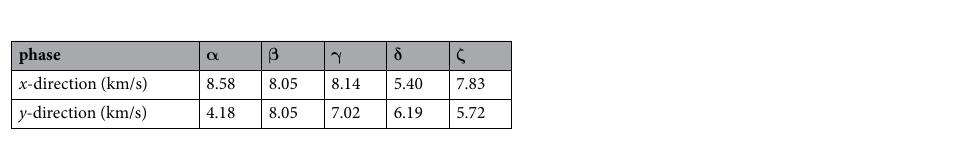
Table 2. The Γ point group velocity of longitudinal acoustic phonons along the x - and y -direction for the five phosphorene